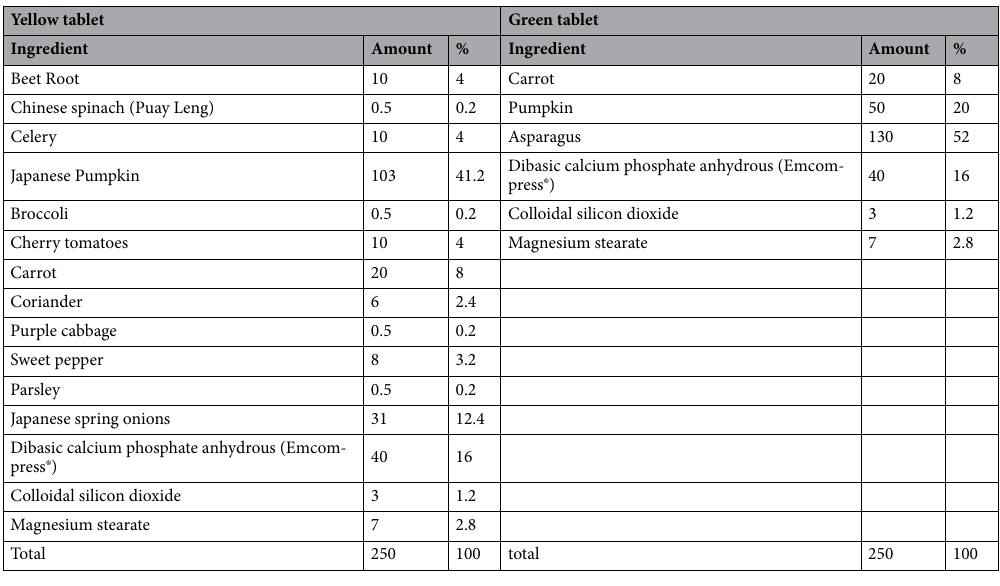
Table 1. Ingredients of yellow and green vegetable tablets (mg/tablet). *Dibasic calcium phosphate anhydrous (Emcompress®) (as filler), Colloidal silicon dioxide (as glidant), Magnesium stearate (as